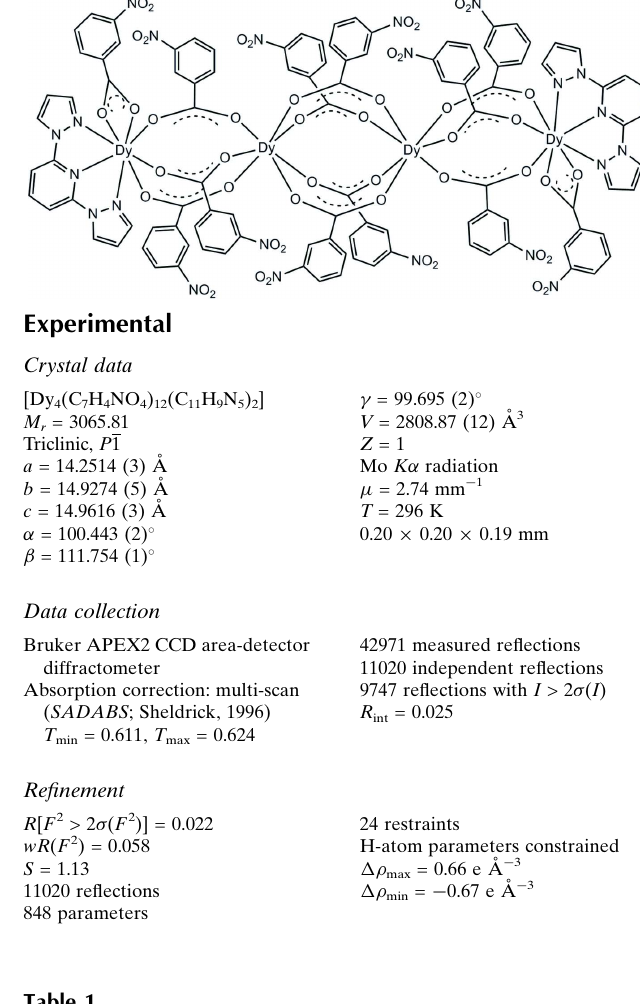
Hydrogen-bond geometry (A˚ , (cid:4)